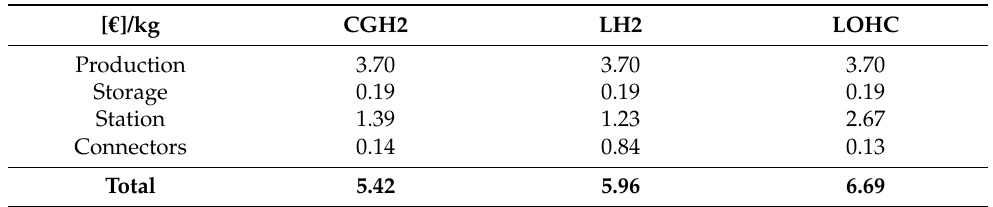
Table 4. Additional supply chain costs without transport (production, storage, fueling station, connectors) for a 75% fleet share of fuel cell vehicles [42].